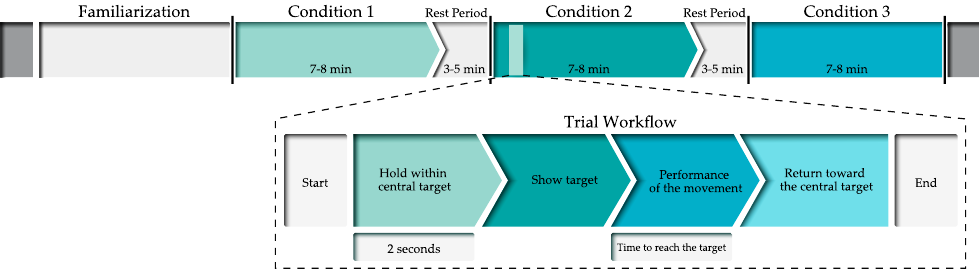
Figure 6. Diagram of the study protocol. The conditions are performed sequentially in random order. After each condition, a rest period of 3–5 min is carried out. This rest period is also used to fill in the